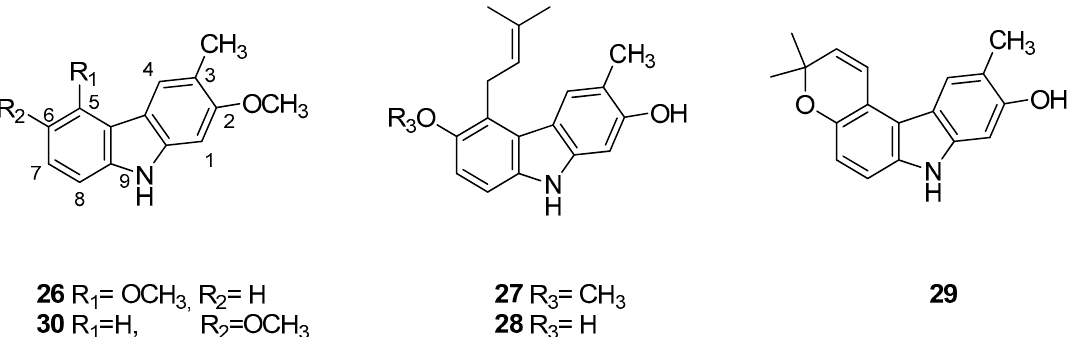
Figure 12. Structures of carbazole alkaloids from Glycosmis arborea ( 26 – 30 ).